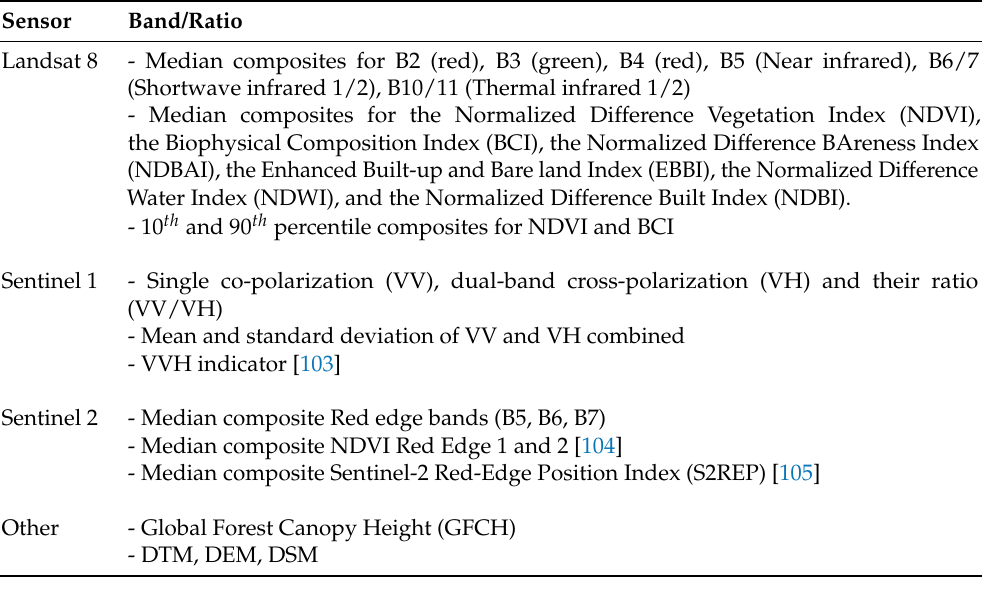
Table A1. Earth observation (EO) input used in the Local Climate Zone mapping procedure. All EO tiles are retrieved between 1 January 2018 and 31 December 2019, using Google Earth Engine. Most input features are also used in Demuzere et al. [28]; if not, additional references are provided.